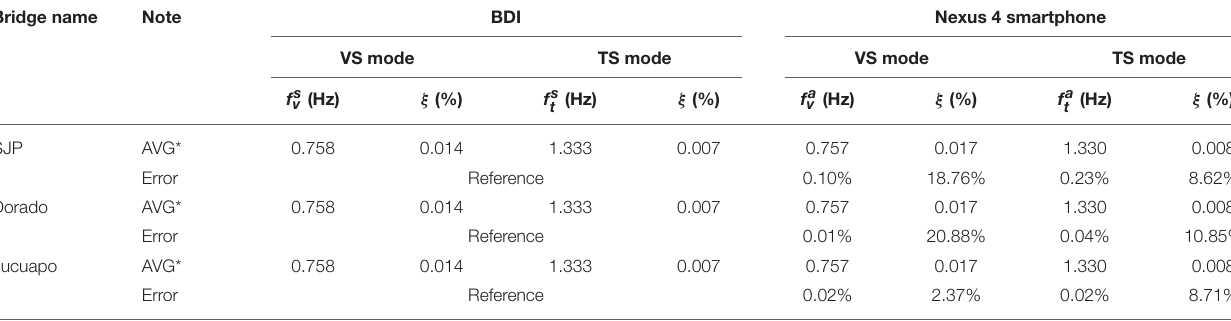
TABLE 1 | Comparison of estimated dynamic properties from BDI and Nexus 4